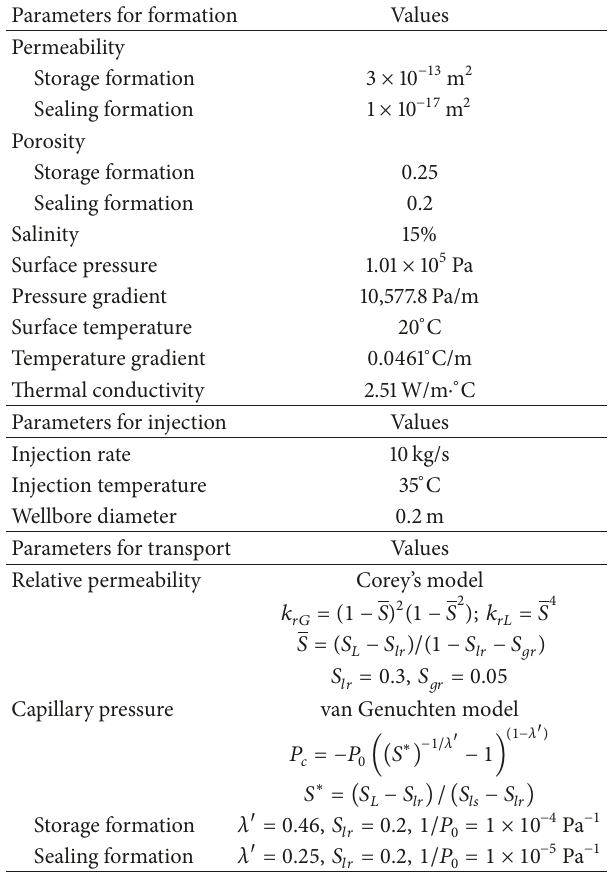
Table 1: Parameters and properties used in the basecase model. The definitions of symbols are explained in nomenclature.